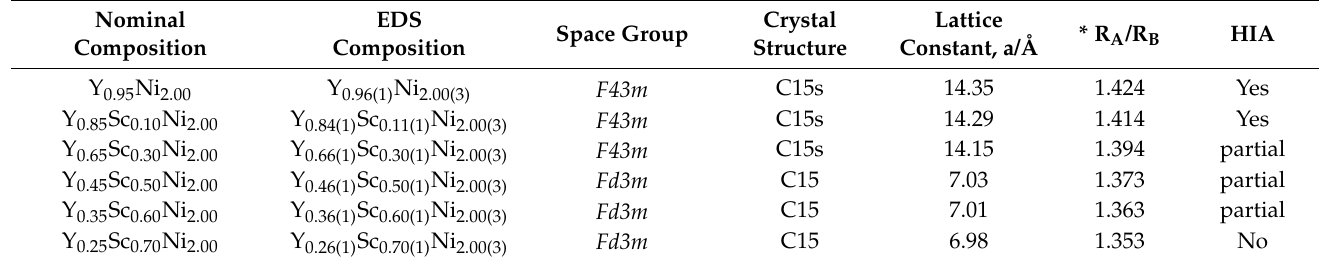
Figure 1. XRD patterns of as-annealed Y-Sc-Ni compounds. Table 1. Structural parameters of Y 0.95 − x Sc x Ni 2